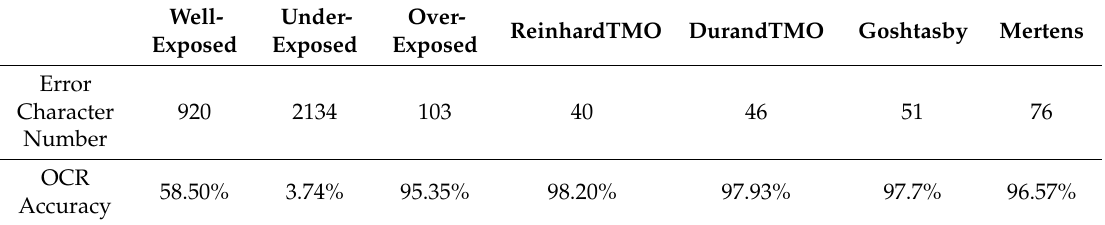
Table 1. Optical Character Recognition (OCR)